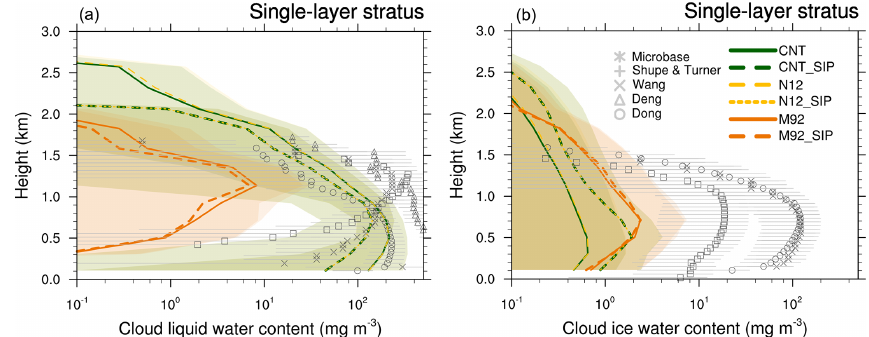
Figure 2. Vertical profiles of LWC (a) and IWC (b) during the single-layer mixed-phase cloud period (9–12 October) from CNT, CNT_SIP, N12, N12_SIP, M92, and M92_SIP experiments and from remote sensing retrievals (symbols). Horizontal gray lines represent standard deviations of retrieval data, and colored shadings are standard deviations of model data. Note that N12 (N12_SIP) coincides with CNT (CNT_SIP) during the single layer stratus cloud period.